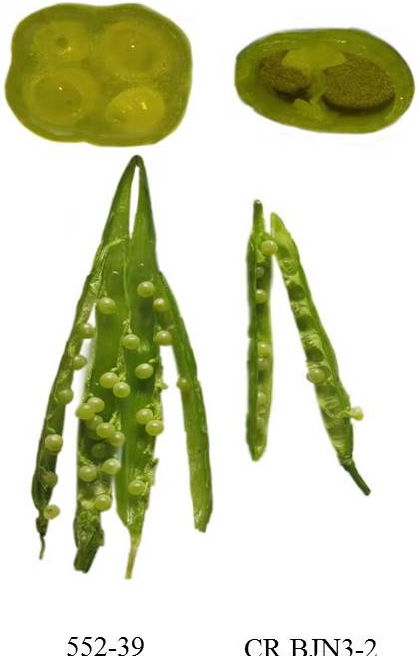
Figure 6. Phenotypic investigation of clubroot resistance for the pyramided line and two parental lines. CR BJN3-2: recurrent parent; BJN3-2: susceptible line as control; 552-39: selected pyramided line.